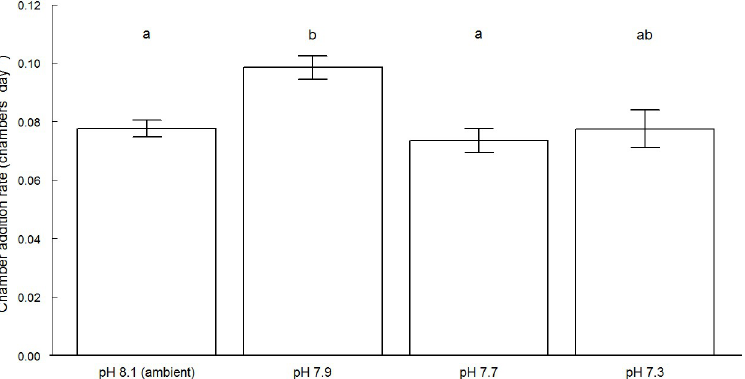
Fig 2. Mean values ( ± standard error) of the chamber addition rate for Elphidium williamsoni cultured at different pH conditions for an experimental period of 42 days. Treatments with significant differences are indicated by different letters (i.e. a and b) above bars at p < 0.05. Treatments with shared letters (i.e. ab) above bars indicate no significant differences (p > 0.05) observed between groups according to the Dunn’s-test.